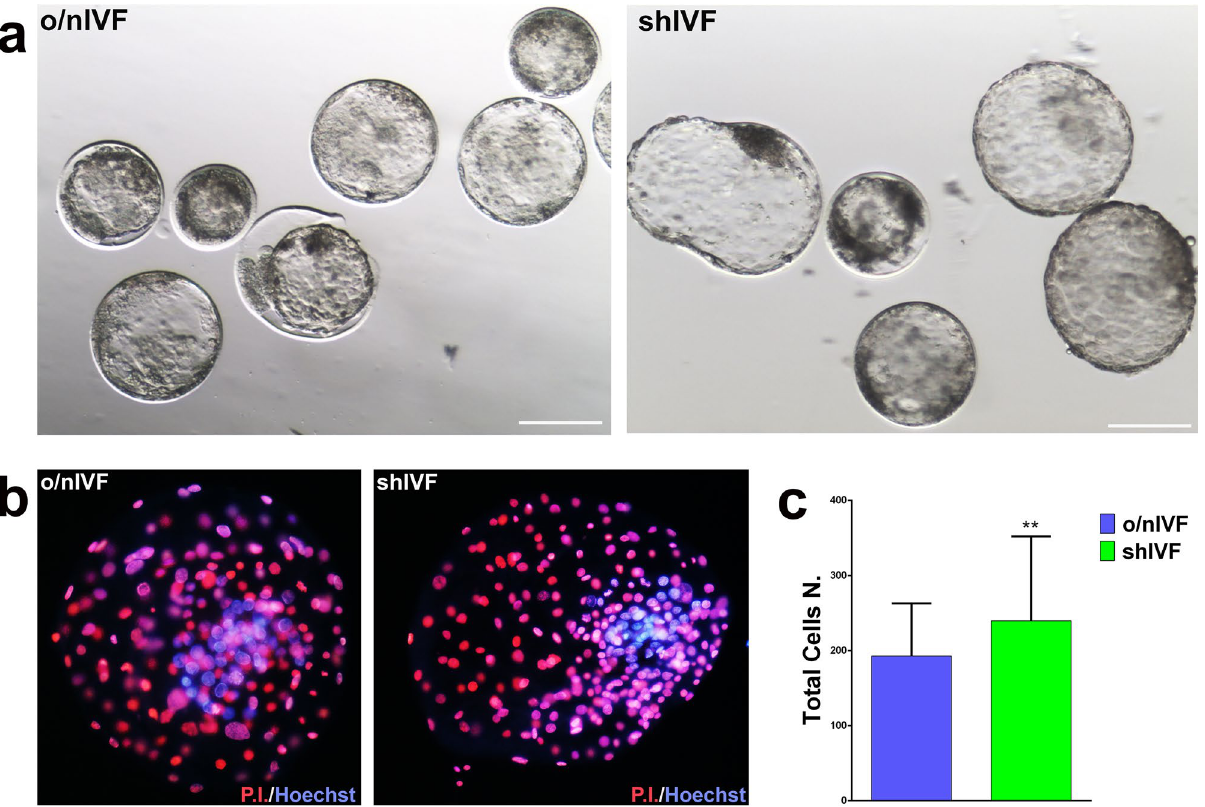
Figure 3. Embryonic development and blastocyst’s cells counting. ( a ) Expanded blastocyst at day 7 of embryo culture produced with convention overnight IVF (on the left) and short IVF (on the right). Scale bar represents: 150 µm. ( b ) Differential staining for blastocyst’s cells counting. On the left, o/nIVF blastocyst, on the right shIVF blastocyst. Chromatin was stained with Hoechst 33,342 (in blue) and Propidium Iodide (in red). ( c ) Graphic representation of blastocyst total cells number. For each comparison a total of 16 blastocysts for o/nIVF and 14 blastocysts for shIVF were evaluated. ** means P = 0.0062.